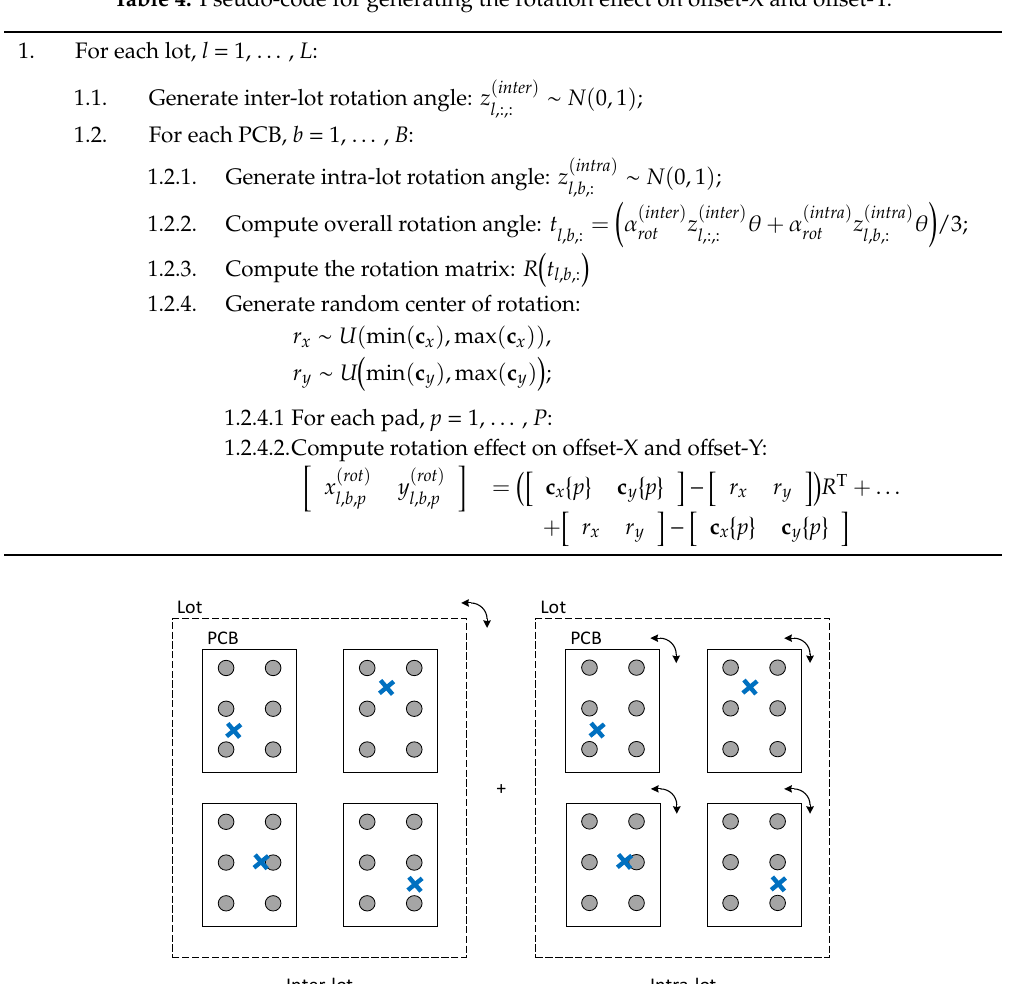
Figure 4. Schematic representation of the inter-lot and intra-lot components used to generate the rotation effect on offset-X and offset-Y. The cross represents the specific center of rotation of each PCB. Along with the translation and rotation effects, the offset-Y is also affected by an additional systematic bias caused by the printing direction of the squeegee (the squeegee is the device that pushes the solder past deposits placed on the top side of the stencil towards the existing apertures in the stencil). This phenomenon leads to a positive deviation in the offset-Y when the printing is performed in one direction and a negative deviation when the printing direction is reversed. Without loss of generality it is assumed that PCBs with an odd index b are printed in the direction of increasing y -coordinates. Conversely, PCBs with an even index b are assumed to be printed in the opposite direction of decreasing magnitude y -coordinates. To simulate the squeegee effect on offset-Y ( ( Table 5. Pseudo-code for generating the squeegee effect on offset-Y. 1.